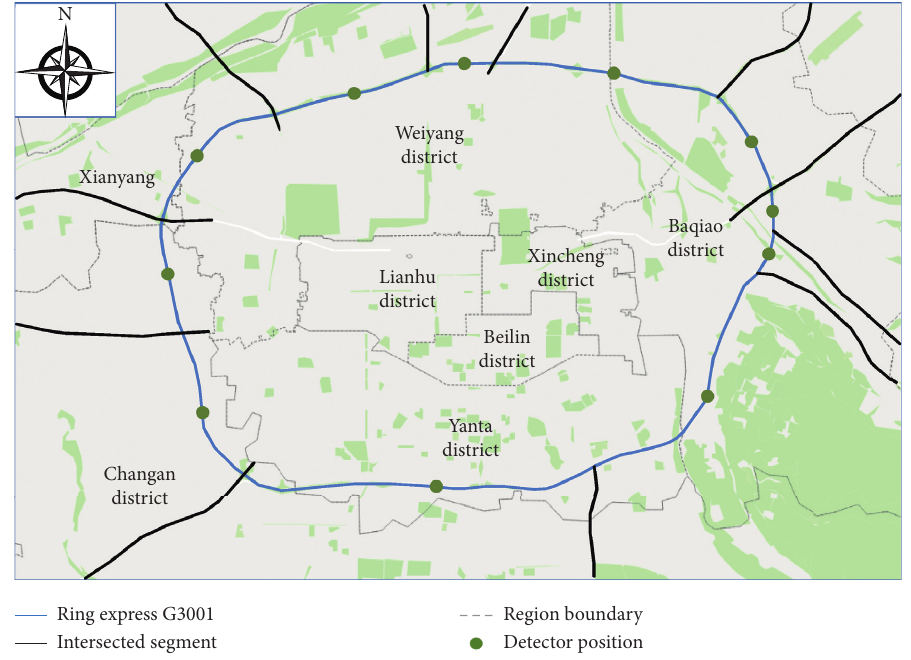
Figure 1: Research objective G3001 and detectors